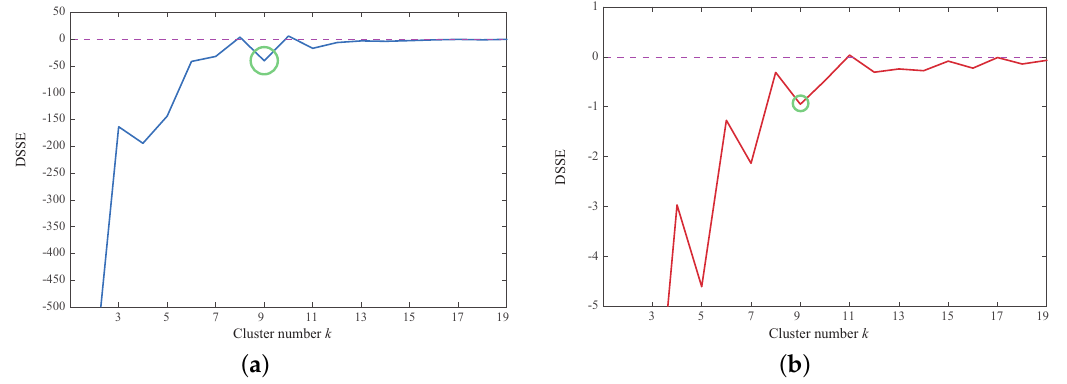
Figure 15. DSSE value comparison: ( a ) commercial area and ( b ) residential